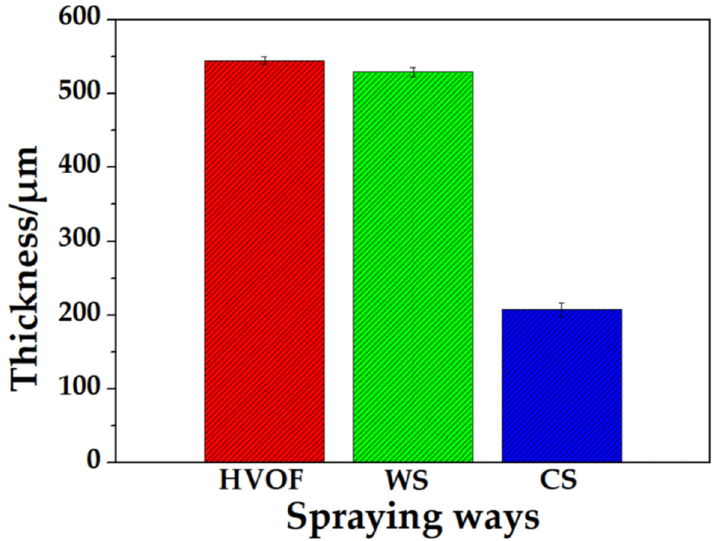
Figure 13. Thickness of WC-17Co coatings formed by various spraying methods.